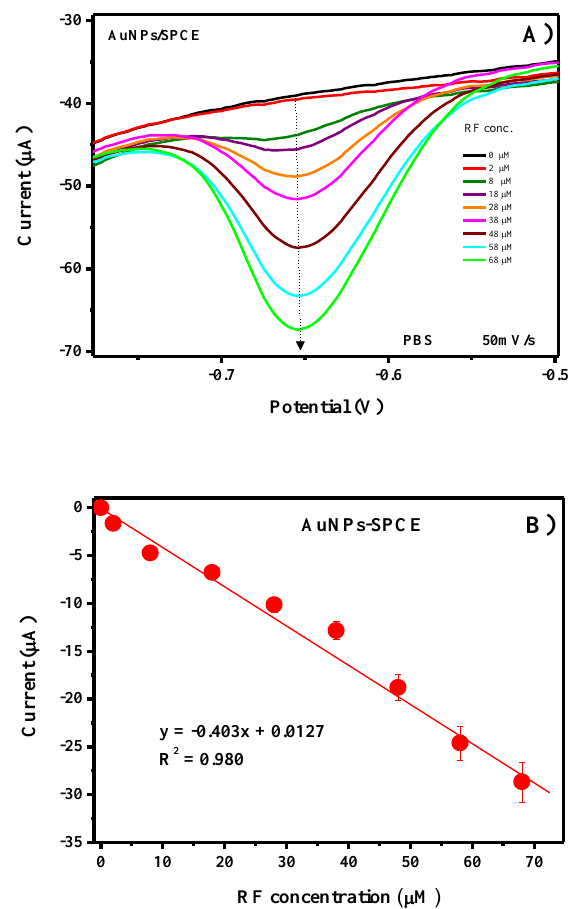
Figure 12. ( A ) Linear Sweep Voltammetry (LSV) of AuNPs/SPCE, performed in 0.1 M PBS electrolyte and in the presence of different concentrations of RF. ( B ) Calibration curve for the determination of RF. The standard deviation of response calculated from data in the calibration curve is